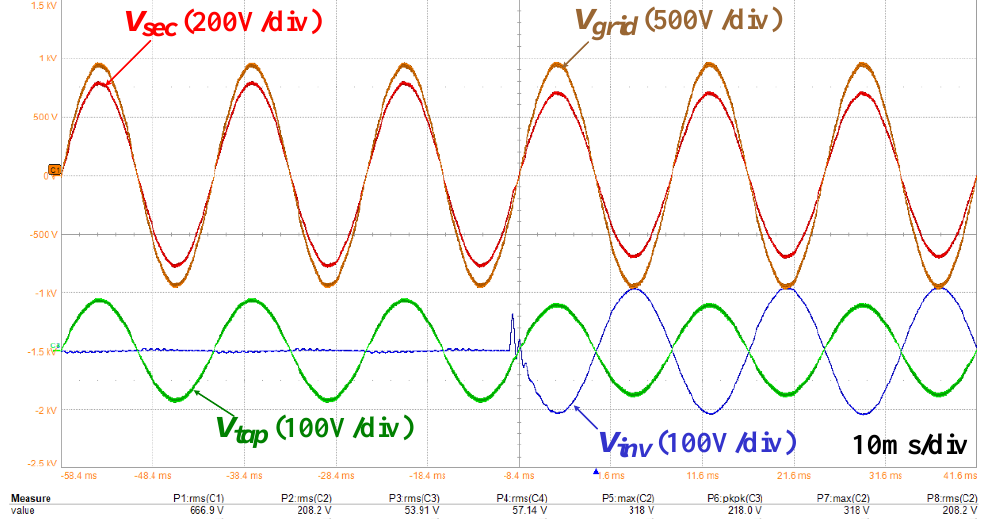
Figure 14. The grid, secondary side, inverter voltage and grid current at the buck mode operation.